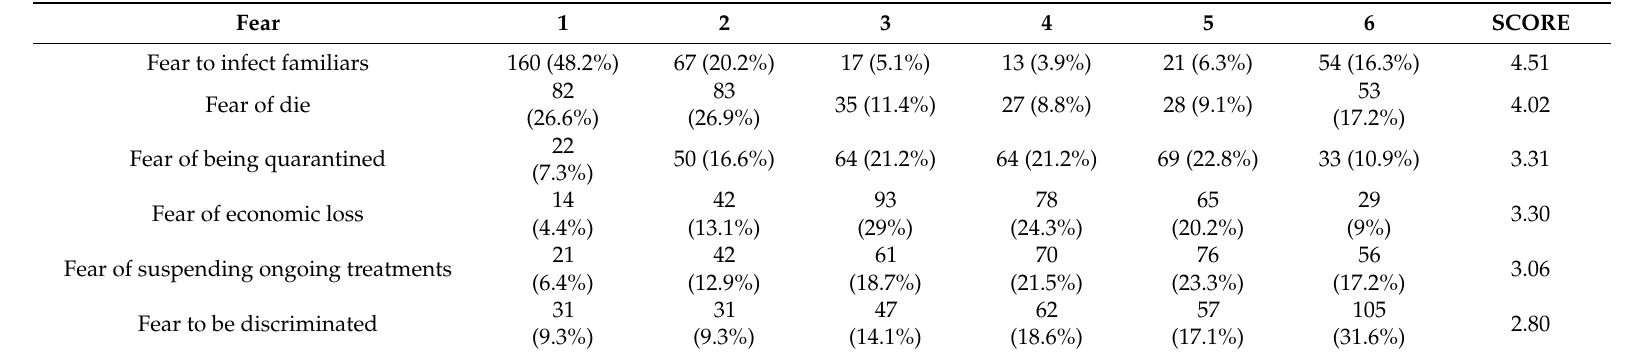
Table 6. Ranking of participants for fears in case of